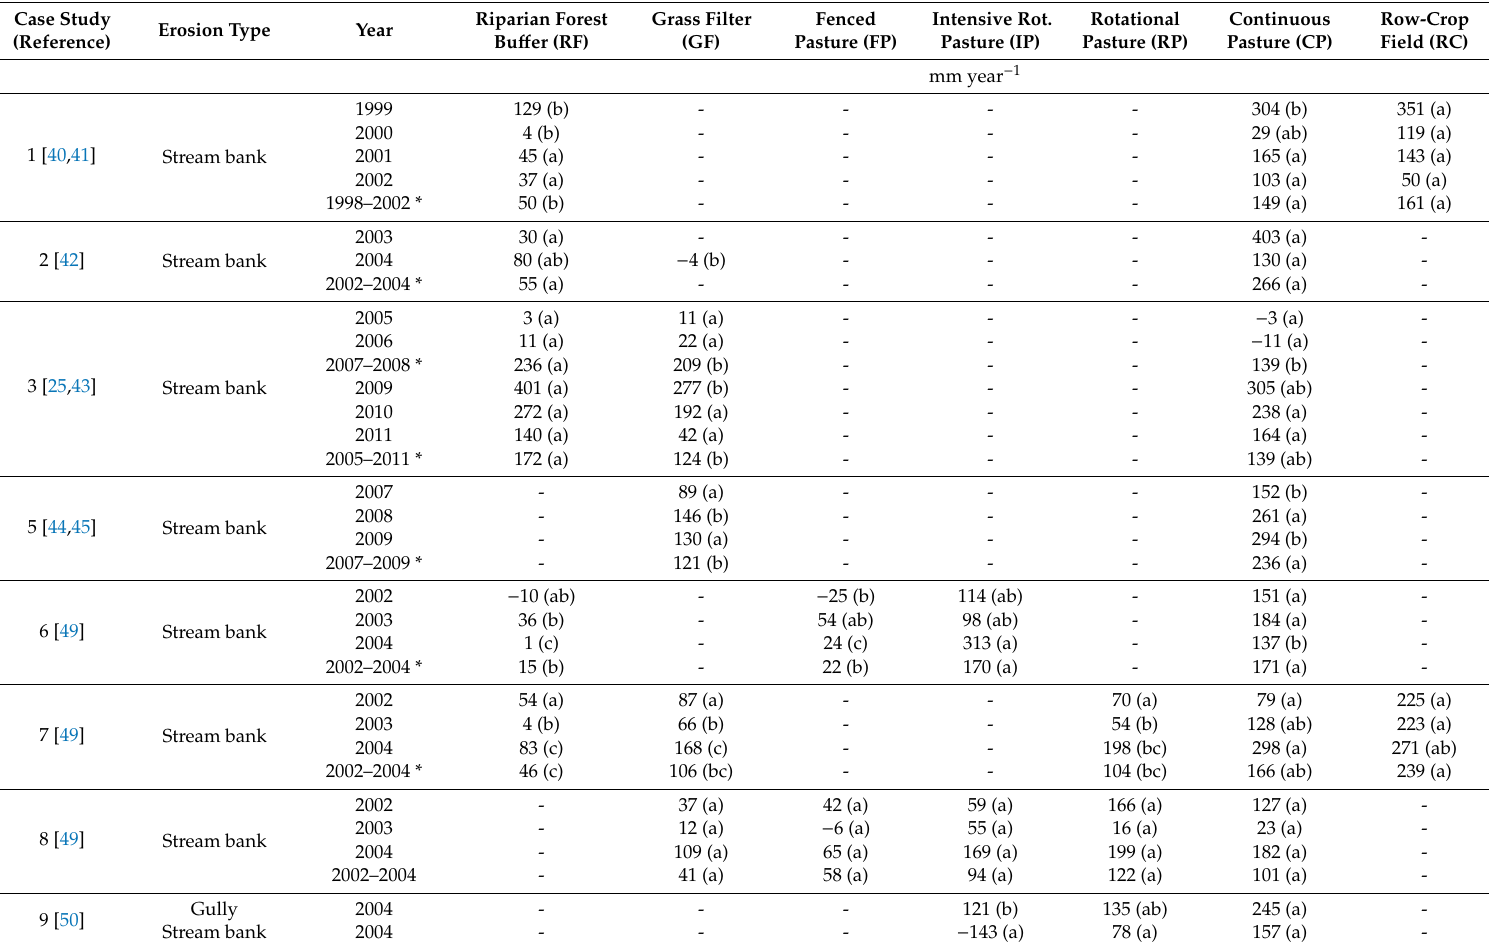
Table 2. The yearly stream and gully bank erosion rates (mm) adjacent to di ff erent riparian land-uses from the di ff erent studies conducted in Iowa. The di ff erent letters in parenthesis indicate statistically significant di ff erences ( p < 0.1) among the di ff erent riparian